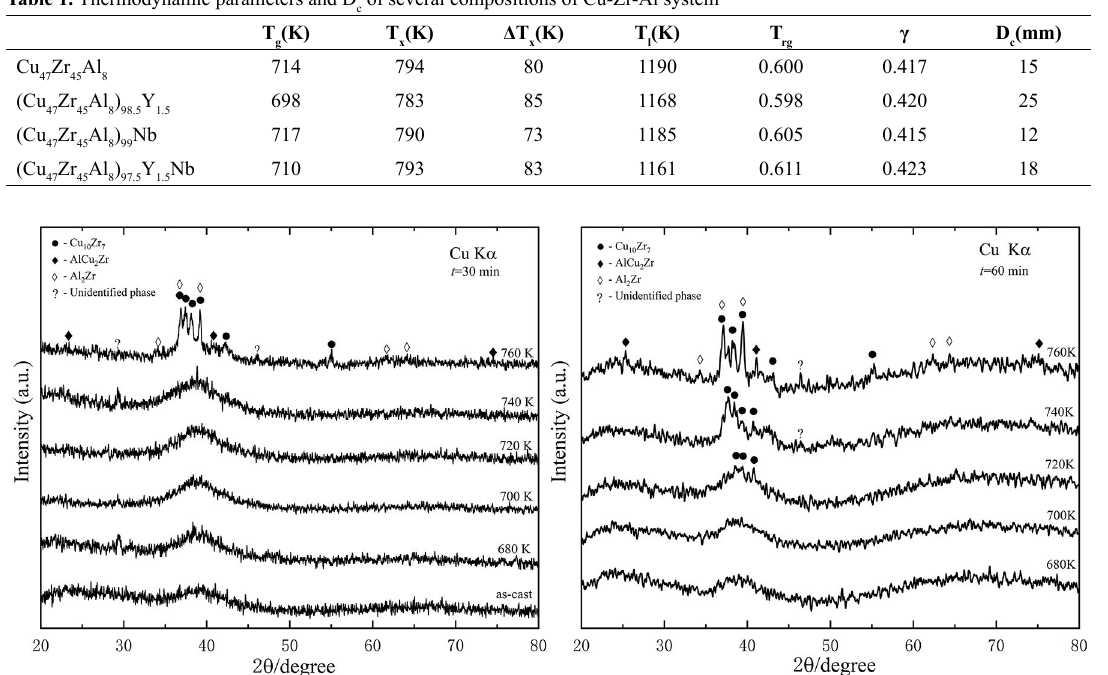
Zr Al ) Y Nb alloys: (a) 30 min; (b) 47 45 8 97.5 1.5